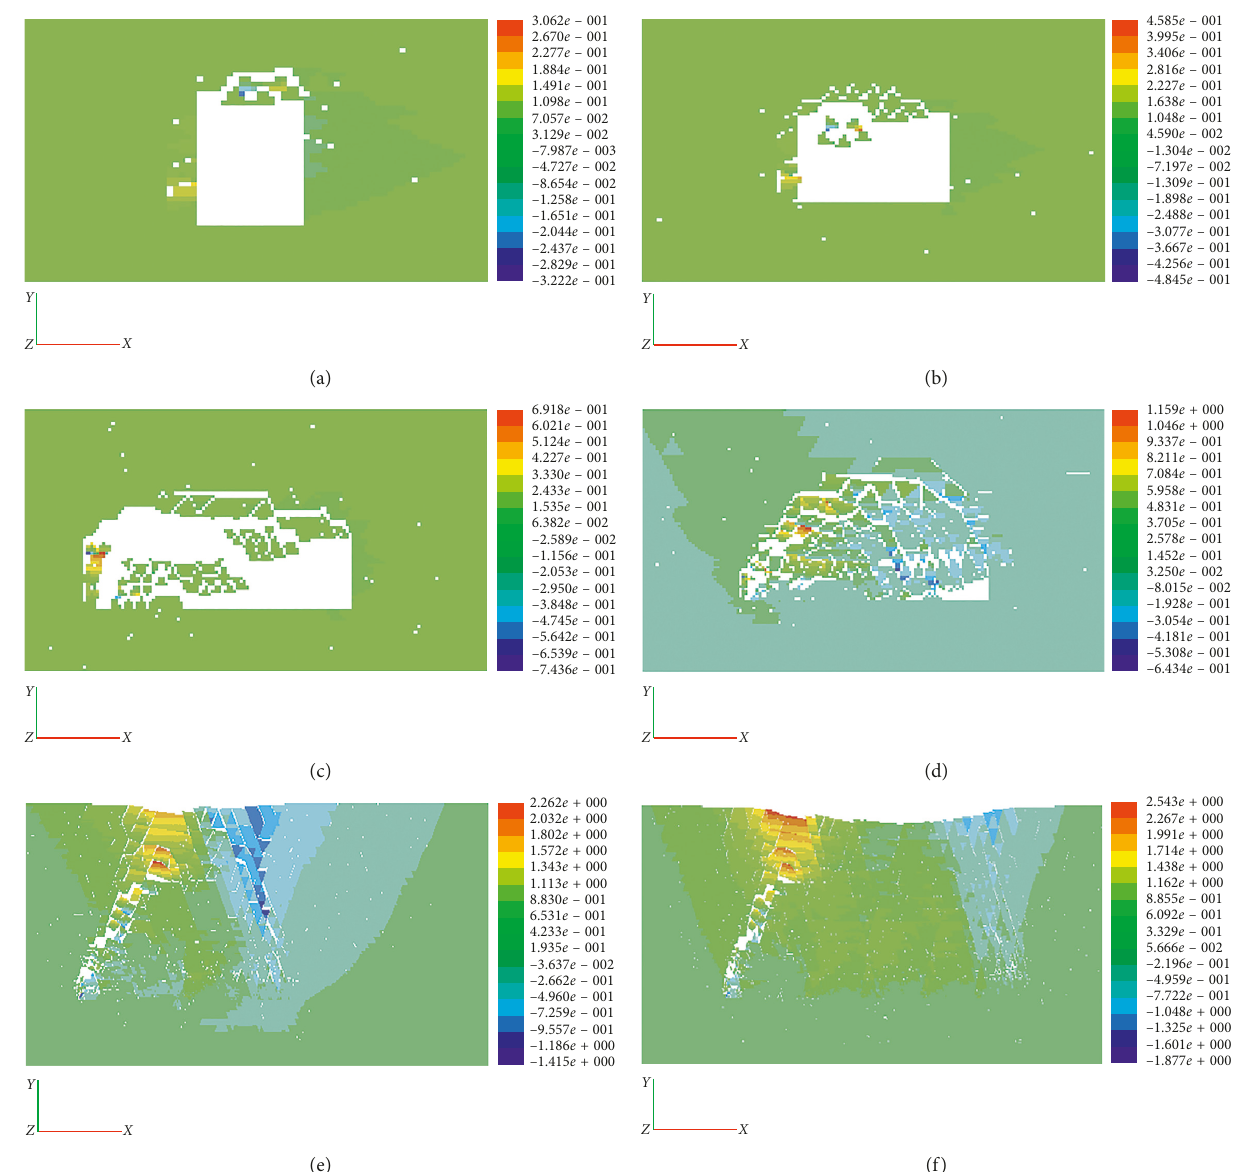
Figure 8: The fracture characteristics and vertical displacement variation of overlying strata during the working face mining. (a) Mining to 4m, (b) mining to 8m, (c) mining to 20m, (d) mining to 40m, (e) mining to 100m, and (f) mining to